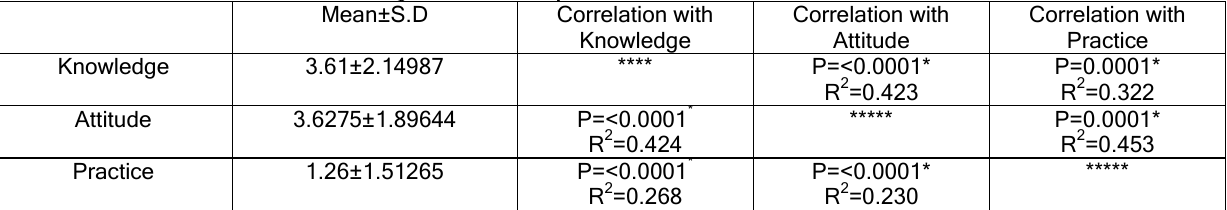
Table 8: Correlation between Knowledge, attitude and practice Mean±S.D Correlation with Correlation with Correlation with Knowledge